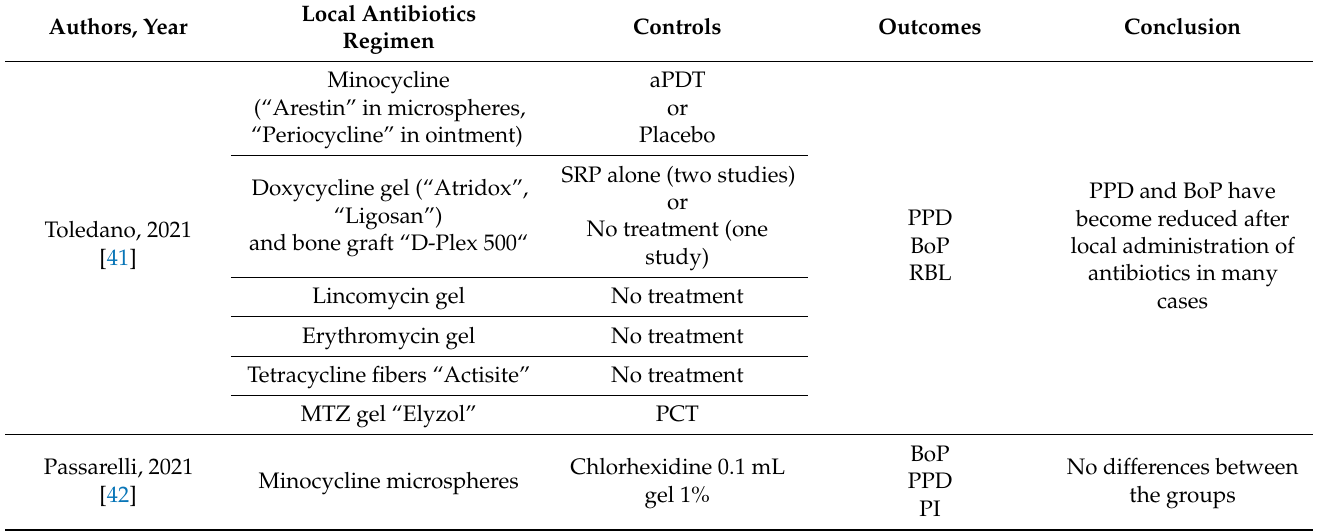
Table 4. Characteristics of locally-delivered antibiotics administered alone in treating peri-implantitis from included